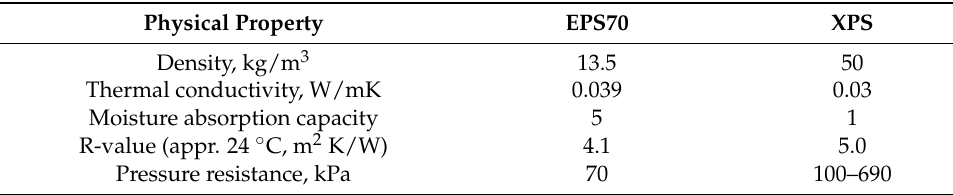
Table 2. Main physical properties of EPS and